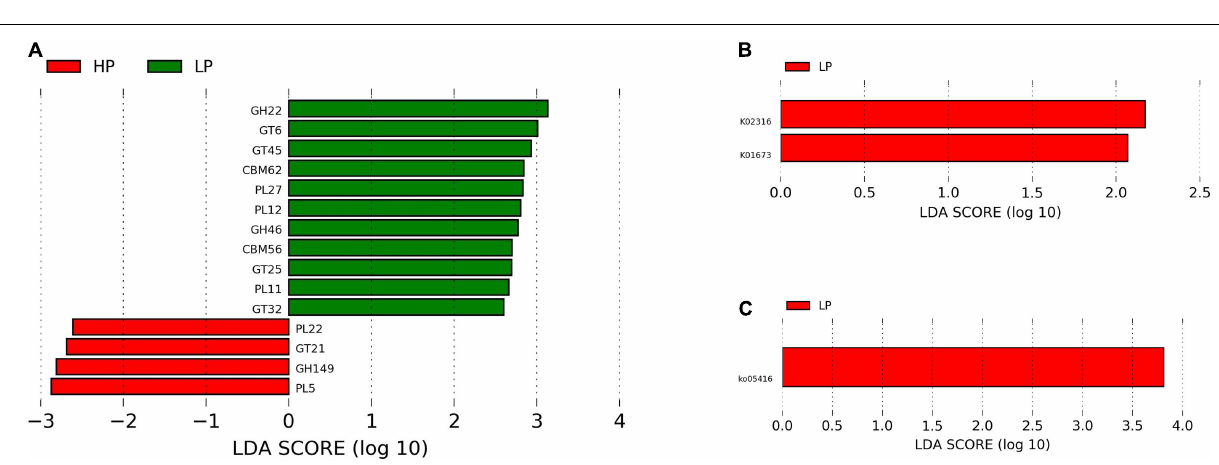
FIGURE 4 | (A) Linear discriminant analysis effect size plot of differential CAZymes ( P < 0.05, LDA > 2) in the HP and LP groups. (B) LefSe plot of differential KEGG genes ( P < 0.05, LDA > 2) in the HP and LP groups. (C) LefSe plot of differential KEGG pathways ( P < 0.05, LDA > 2) in the HP and LP